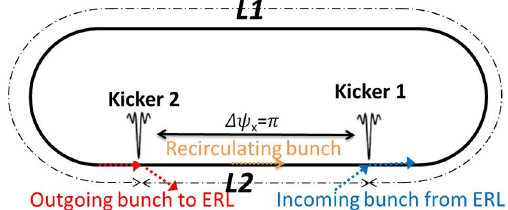
FIG. 5. Two kickers tracking scheme in ELEGANT. Kicker 1 is for injection and Kicker 2 is for extraction.